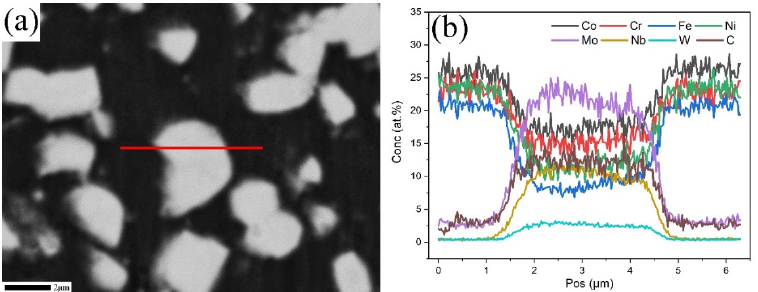
Figure 2. ( a ) Microstructure image and ( b ) the distributions of elements in matrix phase and carbide phase of the HEA by electron probe microanalyzer (EPMA).